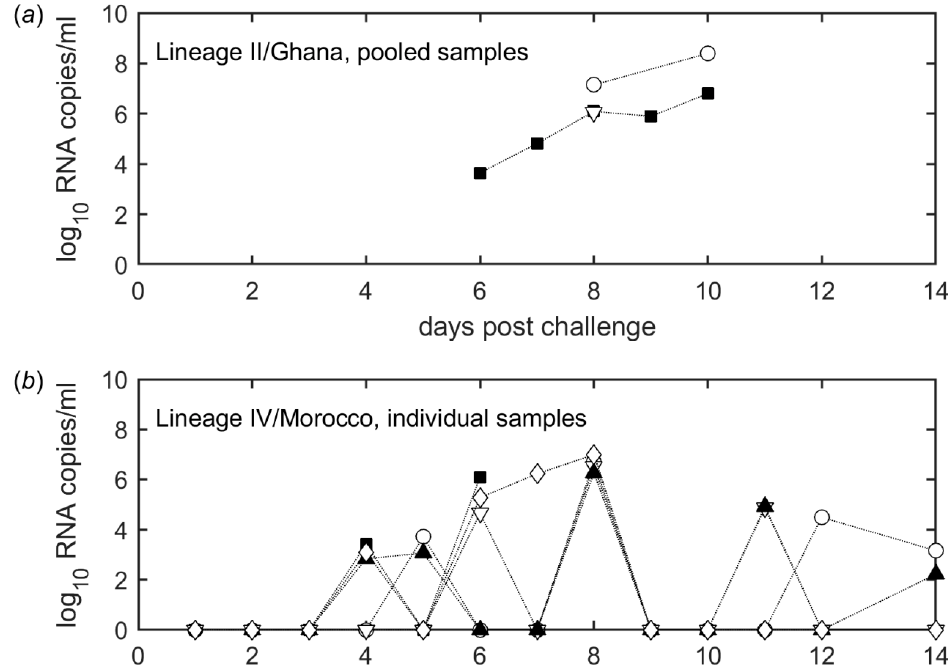
Figure 4. Detection of PPRV RNA in feces. ( a ) Pooled samples from goats infected with the Lineage II/Ghana strain. The same symbols indicate fecal samples taken from the same pool. ( b ) Samples from individual goats infected with the Lineage IV/Morocco strain. The same symbols indicate fecal samples taken from the same animal.